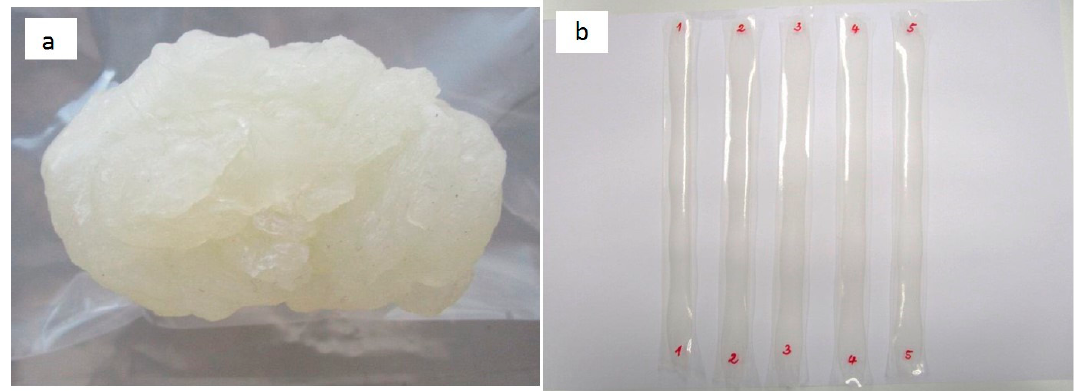
Figure 2. ( a ) Composite 10ST40 after processing in the internal mixer; ( b ) 10ST40 composite film specimens for tensile characterization. specimens for tensile